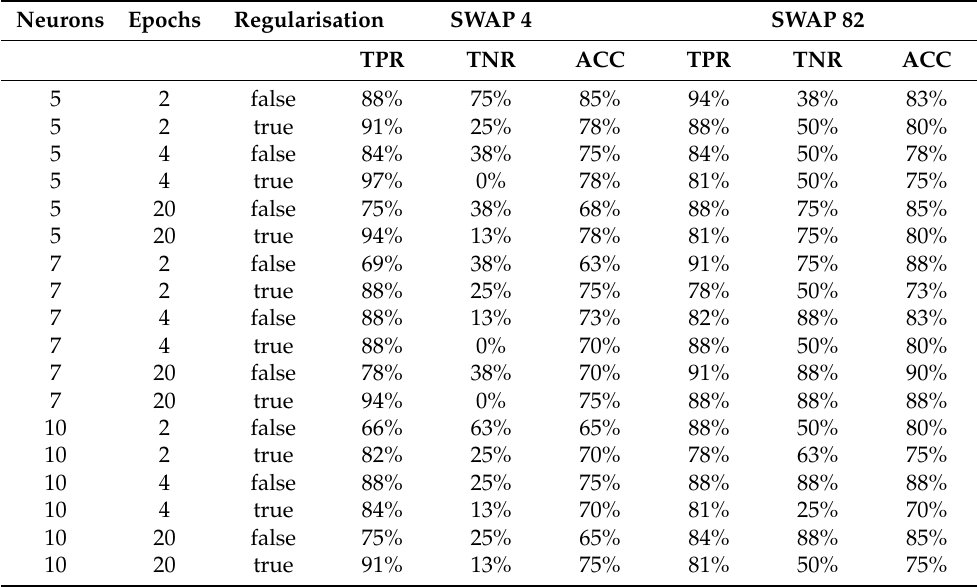
Table 4. Sensitivity (true-positive rate, TPR), specificity (true-negative rate, TNR), and accuracy (ACC) for the faller classification using the SWAP 4 and SWAP 82 tasks.